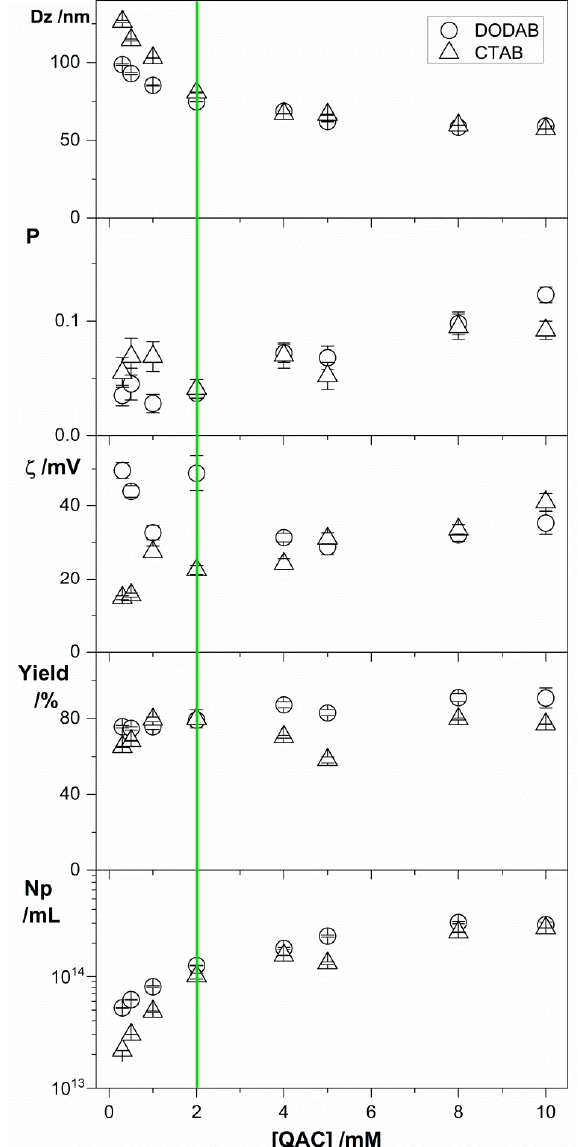
Figure 3. Physical properties of PMMA / QAC NPs obtained by emulsion polymerization over a range of [QAC] at 0.4 M MMA during particle synthesis where QAC is DODAB ( ○ ) or CTAB ( ∆ ). All dispersions were exhaustively submitted to dialysis in pure water before measurements.